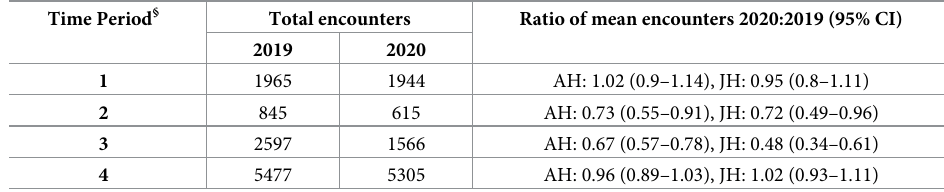
Table 1. Total surgical encounters (for Allegheny Health (AH) and Johns Hopkins (JH), combined).